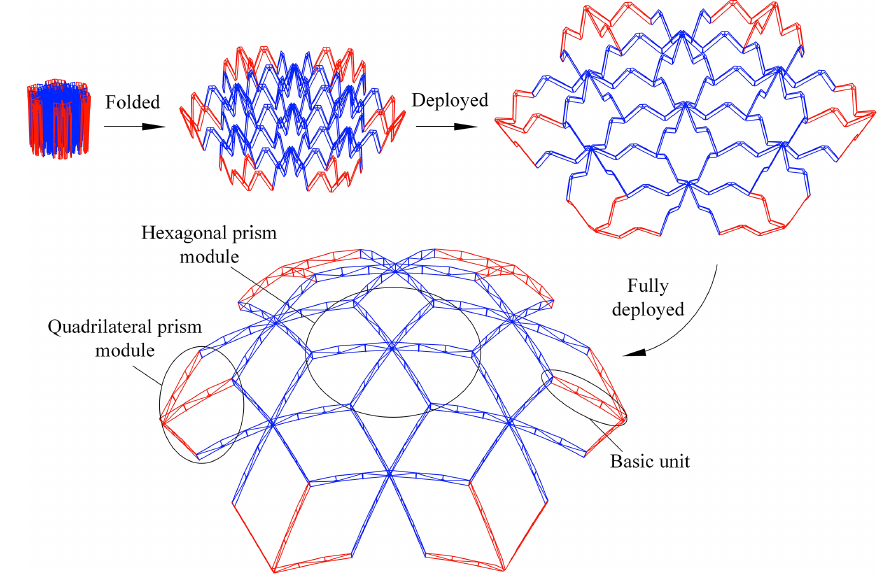
Figure 1. General structure of a multifold rib deployable antenna (without a tension cable).